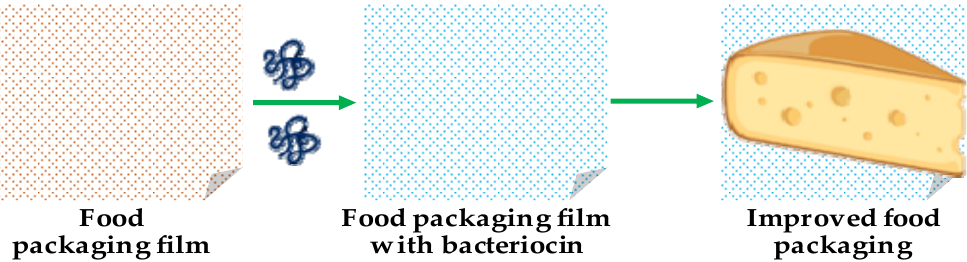
Figure 3. Schematic representation of improved food packaging with bacteriocin.